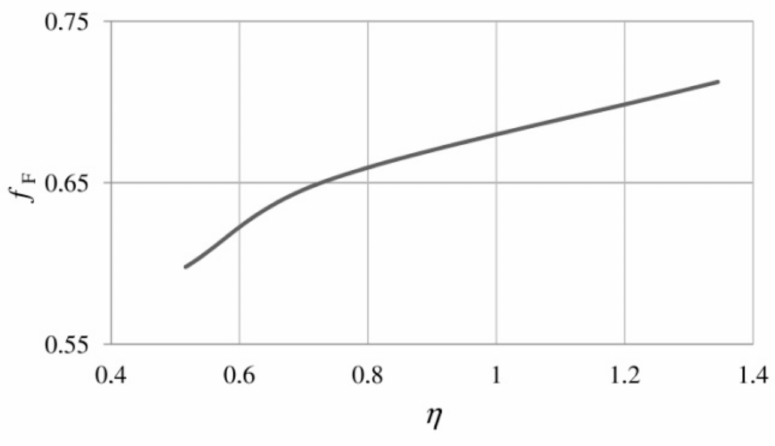
Figure 9. Effect of stress triaxiality on the void volume fraction at failure [47].